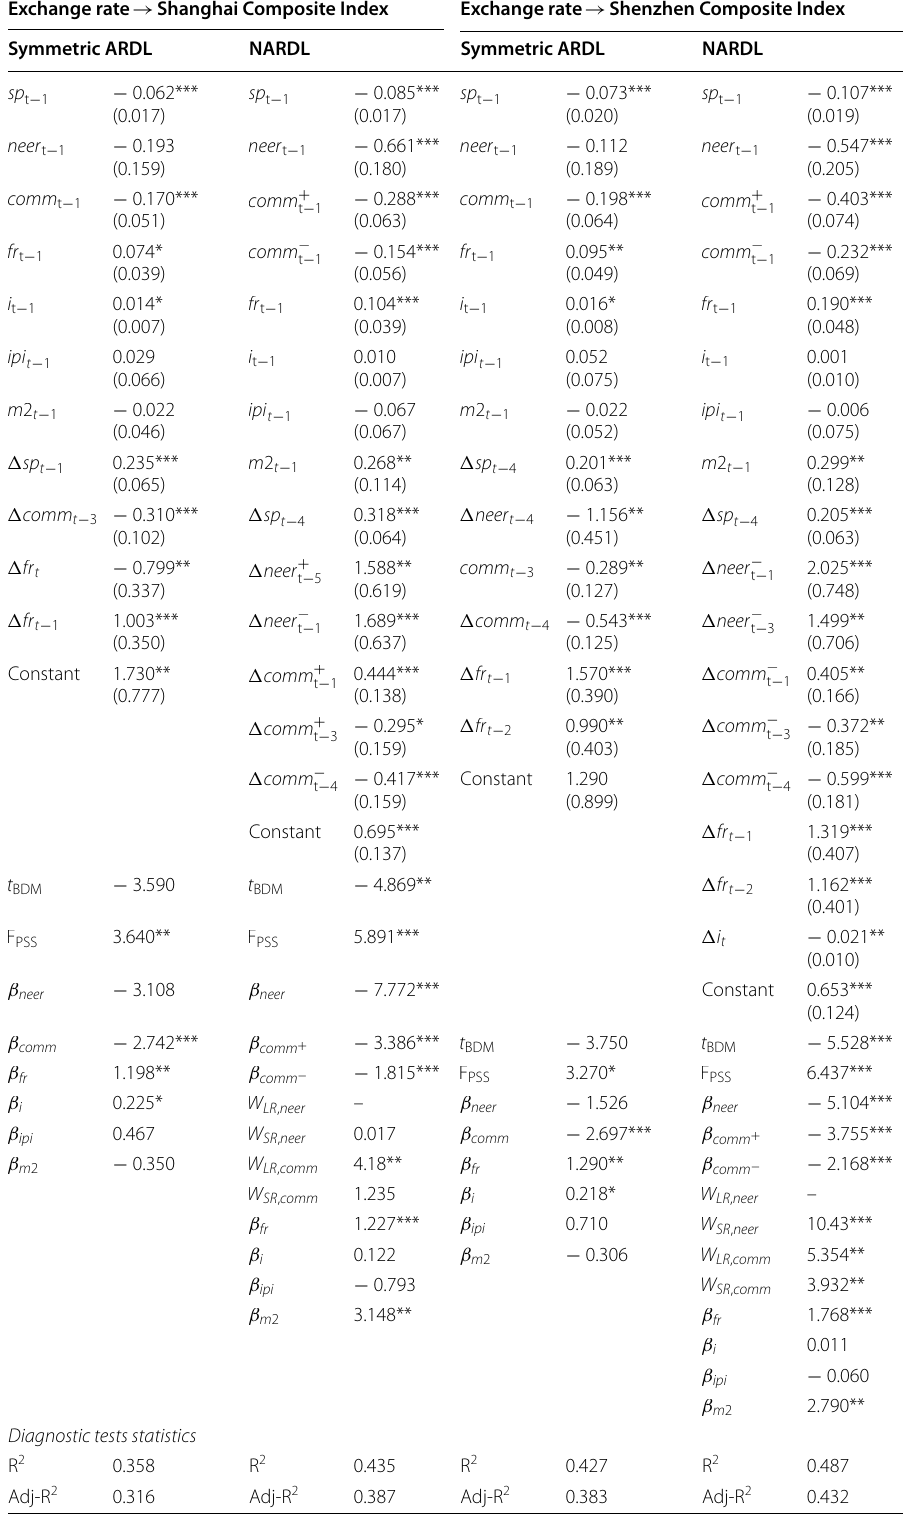
Table 3 Symmetric and asymmetric estimation results for exchange rates and commodities prices pass through to stock